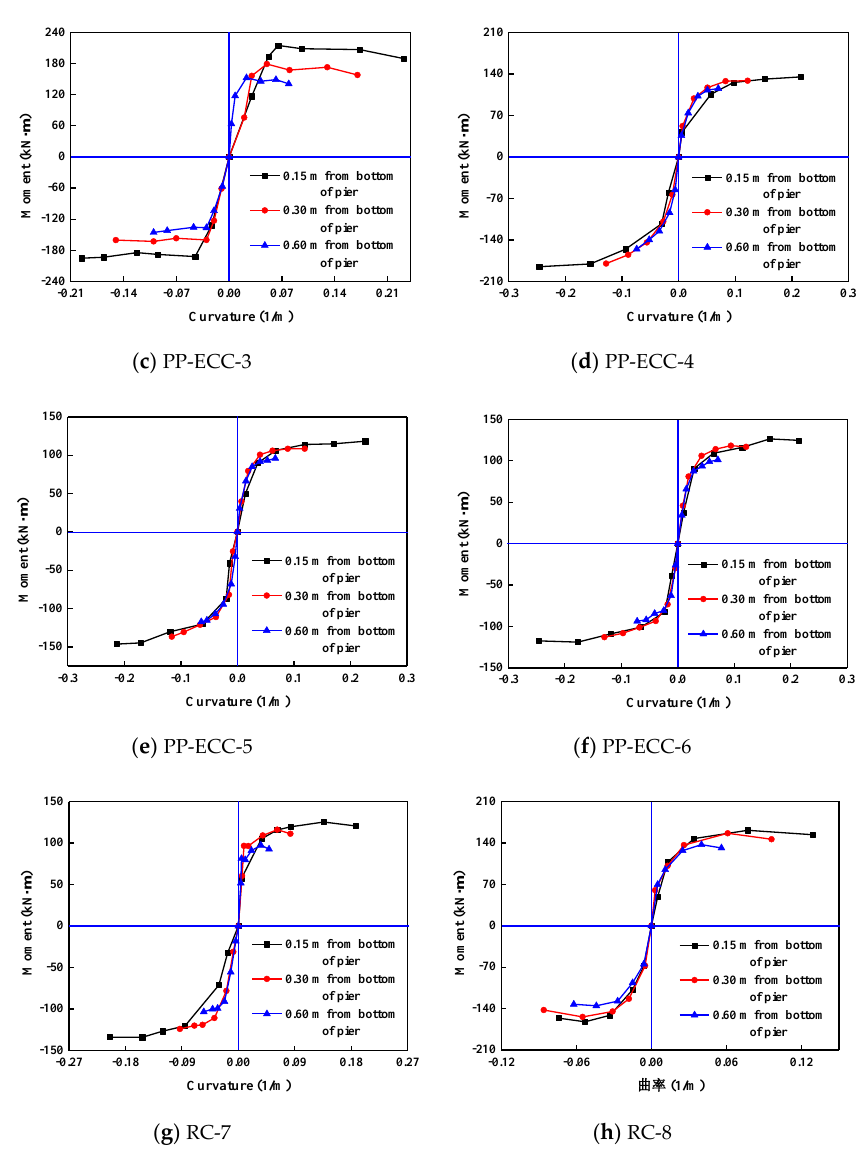
Figure 11. Moment-curvature skeleton curves of piers.